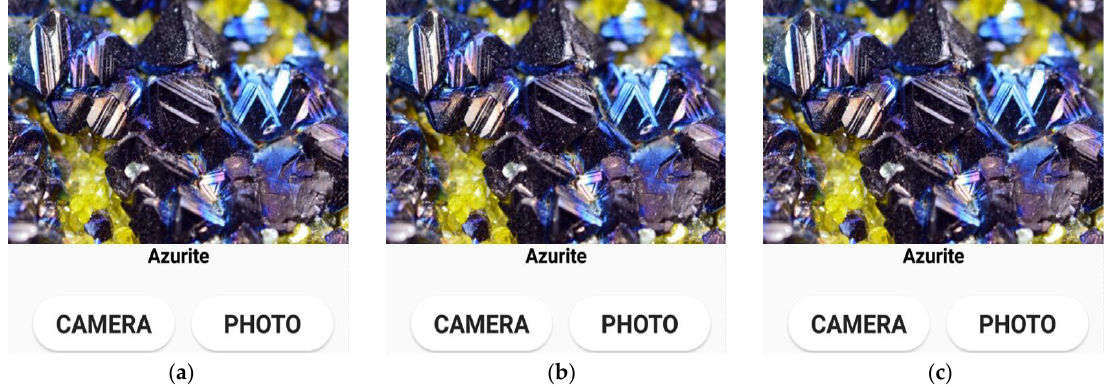
Figure 10. Identification results from these three models. ( a ) True; ( b ) true; ( c ) true.